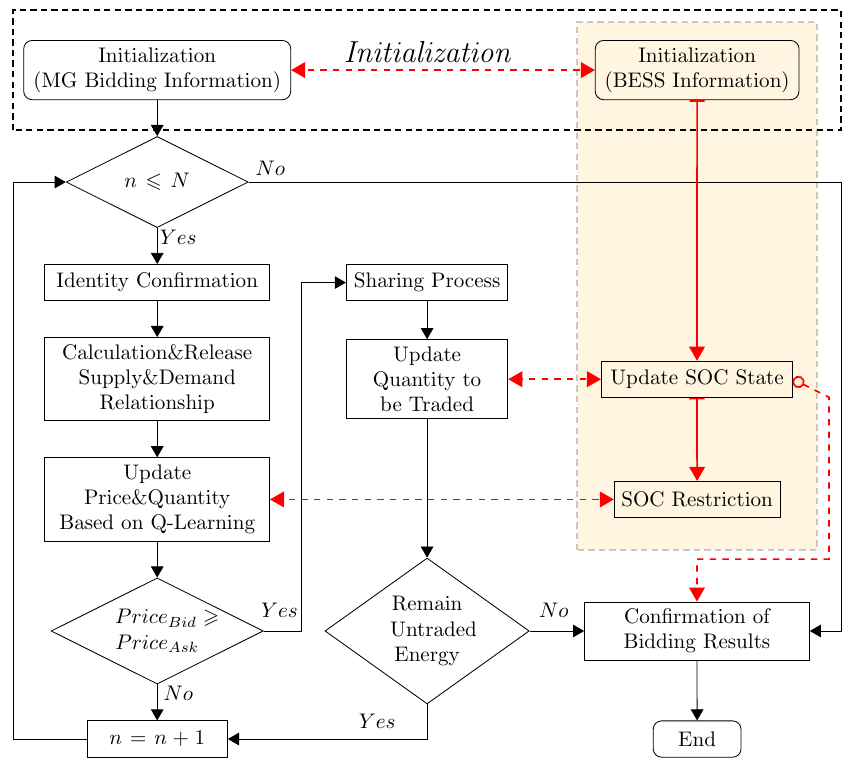
Figure 2. The process of Q-learning based continuous double auction in one time